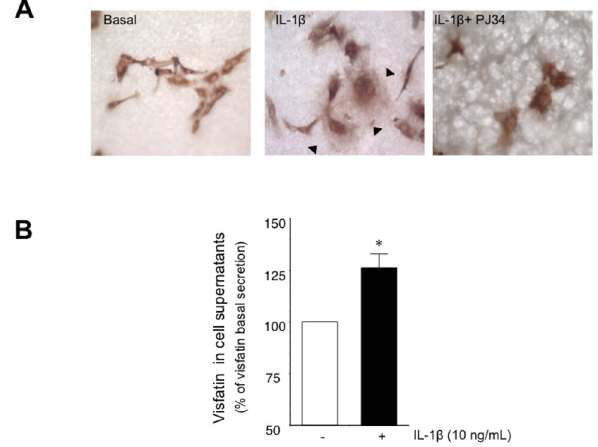
Figure 4. Inflammation promotes visfatin secretion by